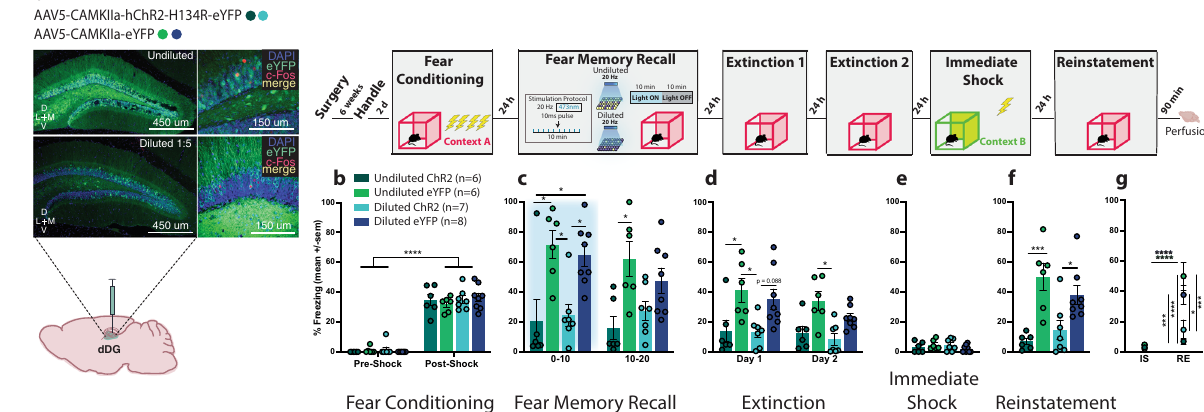
Fig. 4 | Activation of randomly labeled dDG is also suf fi cient to disrupt fear reconsolidation. a Viral strategy and experimental design. We used a virus with a constitutivepromotertorandomlylabeldDGneuronsnottiedtotheencodingofa behavioral epoch. Mice were injected with either undiluted or diluted virus. The experimental procedure was similar to the previous experiments with the excep- tion of the neuronal tagging component. b During FC, all mice froze post-shock (three-way RM ANOVA: F(1,23)=447.9, P <0.0001). c During recall, stimulation produced decreases in freezing in both the undiluted ( P =0.0106) and diluted ( P =0.0369) ChR2-groups compared to eYFP-controls (three-way RM ANOVA: F(1,23)=25.67, P <0.0001, Virus). In the latter half of the session, mice in the undiluted ChR2 continued to show decreased freezing compared to eYFP-controls